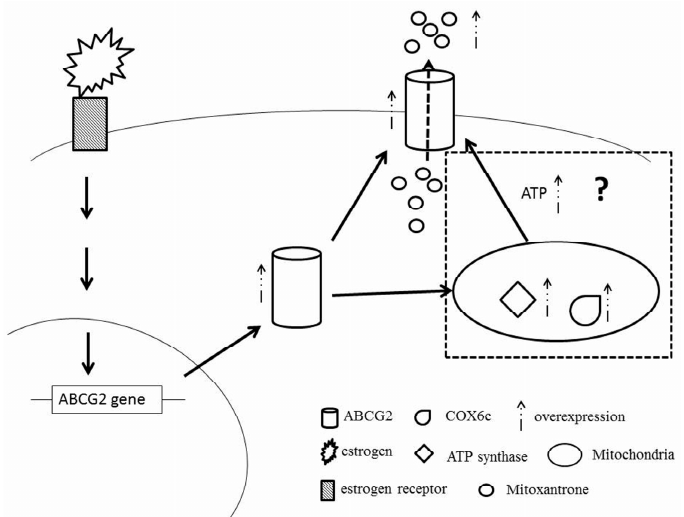
Figure 8. Overview figure. The binding of estrogen and its receptor induced the ABCG2 gene and the over-expression of ABCG2 modulated MCF7 cells to pump out MX more efficiently. Furthermore, we speculated that the over-expressed ABCG2 imported into mitochondria to stimulate the expression of ATP synthase and COX6c or to interact with over-expressed ATP synthase and COX6c to enhance the tolerance of MCF7 to MX.